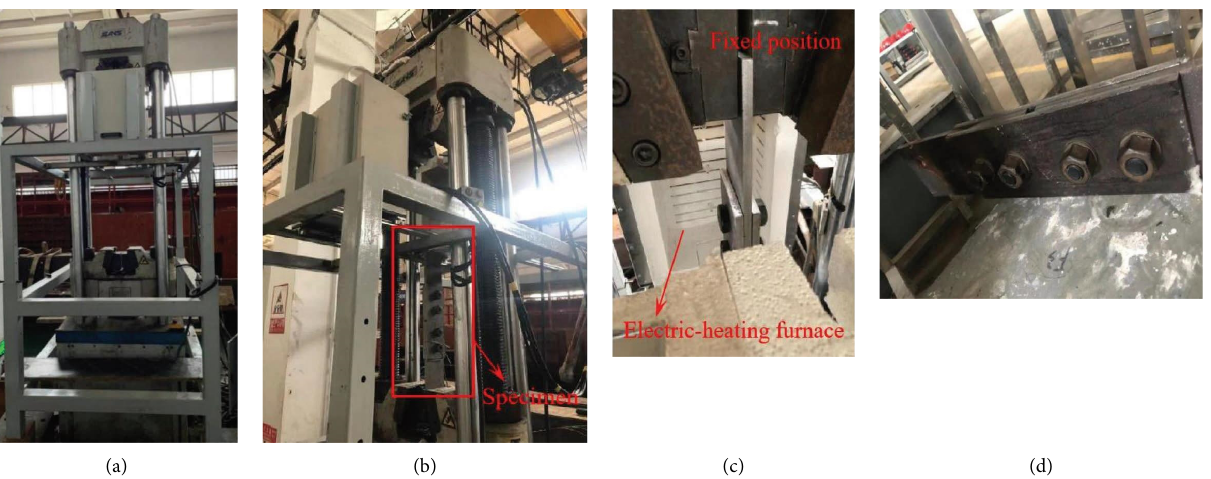
Figure 2: MTS high-temperature testing machine and the specimen at elevated temperatures. (a) A testing machine. (b) Installation of the specimen. (c) Local details. (d) Details of the specimen.